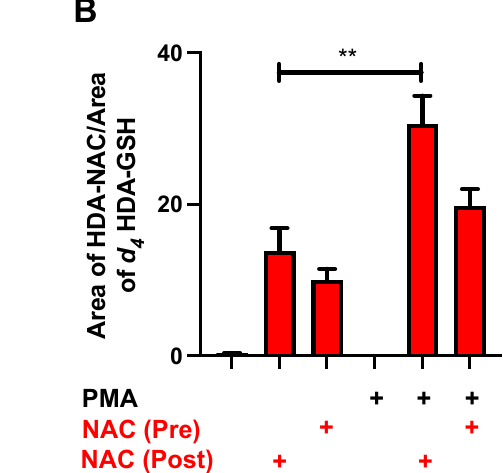
Figure 8. HDA–NAC adduct formation in human neutrophils treated with NAC. In total, 2 × 10 6 neutrophils were pretreated (Pre) with 12 mM NAC for 30 min as indicated before activation with 200 nM PMA as indicated. In separate experiments, 12 mM NAC was added to neutrophils as indicated 25 min after PMA activation (Post). HDA–GSH ( A ) and HDA–NAC ( B ) were measured as described in “Materials and Methods”. n = 3 for each treatment from independent experiments. ** and **** indicate p < 0.01 and p < 0.0001 for indicated comparisons determined by ANOVA with Tukey’s post-hoc test.